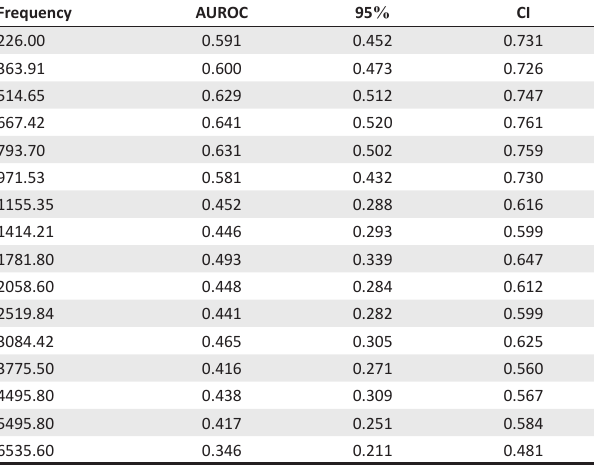
TABLE 2 : Area under the curve for wideband absorbance measure.